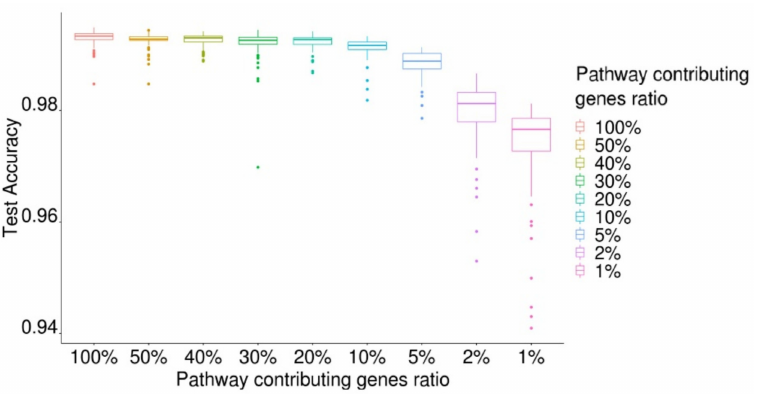
Figure 4. PathDeep performance using pathway-contributing gene ratio.